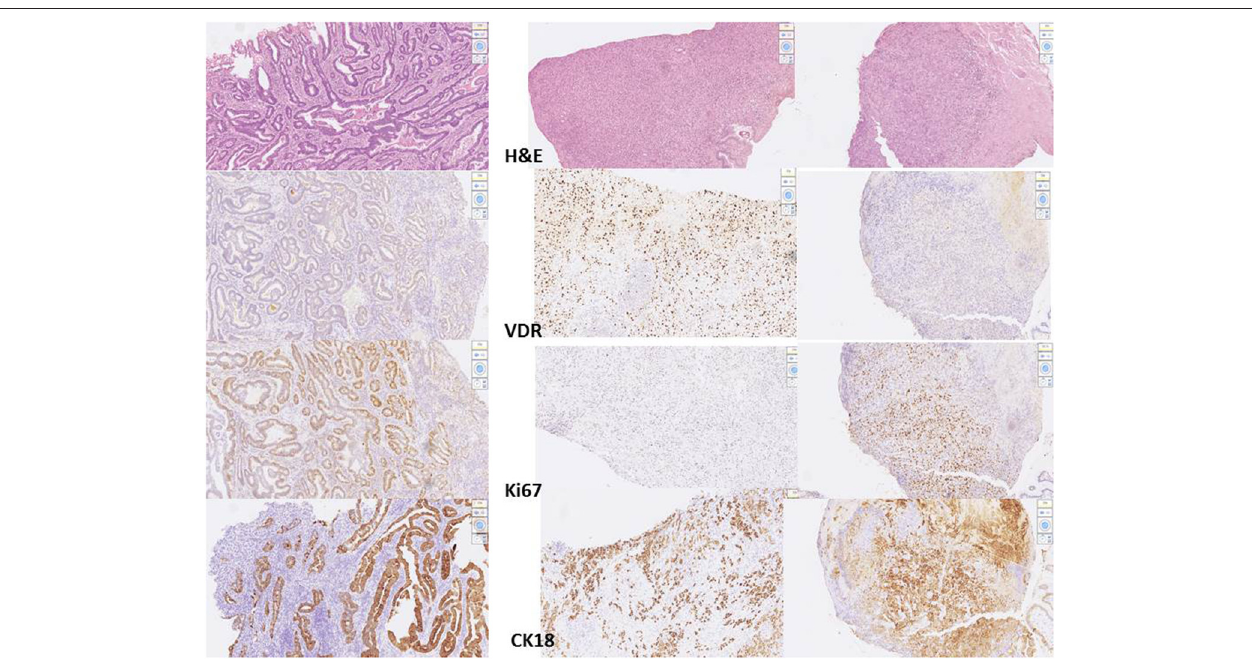
FIGURE 5 | Digital images for different cell type of adenocarcinoma from 3 patients. Left: moderate differentiated adenocarcinoma, stage III. Middle: poor differentiated adenocarcinoma, stage I. Right: poor differentiated adenocarcinoma, stage III. From the top to the bottom: H&E stain, VDR, Ki67, CK18 stain processed by scanner and QuPath